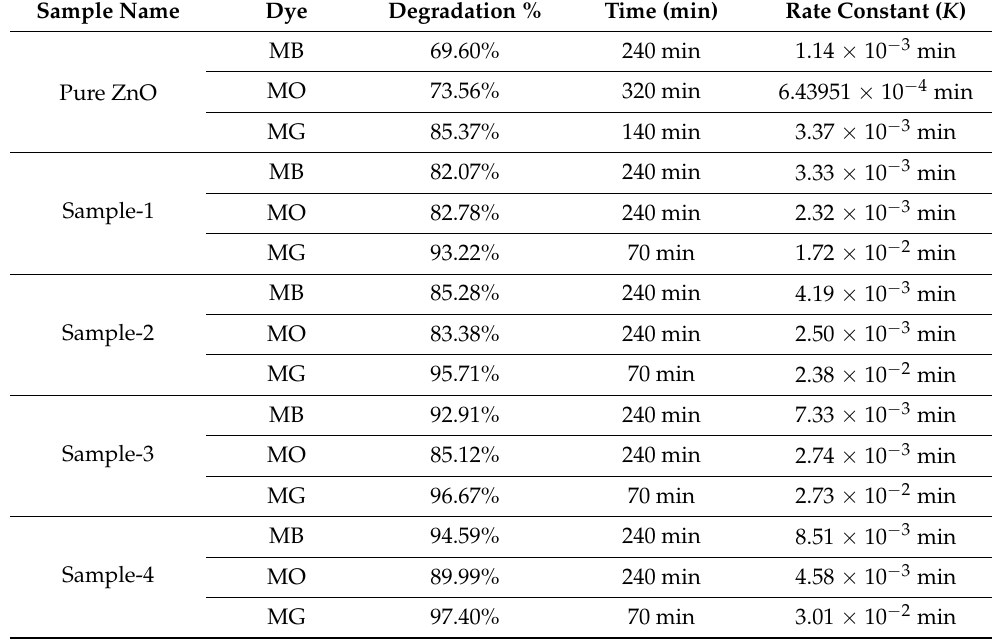
Table 1. Summary of obtained results for the photodegradation of various dyes using different Mn 3 O 4 @ZnO hybrid materials in comparison with pure ZnO.